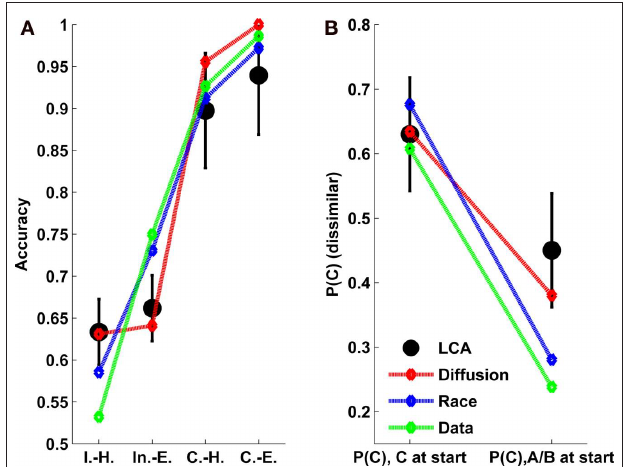
Figure 8 | The average choice for the best (A) option for the first four conditions (left) and the choice of the dissimilar (B) option, in the correlation condition (right). Experimental results are shown with black circles (error bars correspond to 95% CI) while model fits with dashed lines (Red-LCA; blue-diffusion,